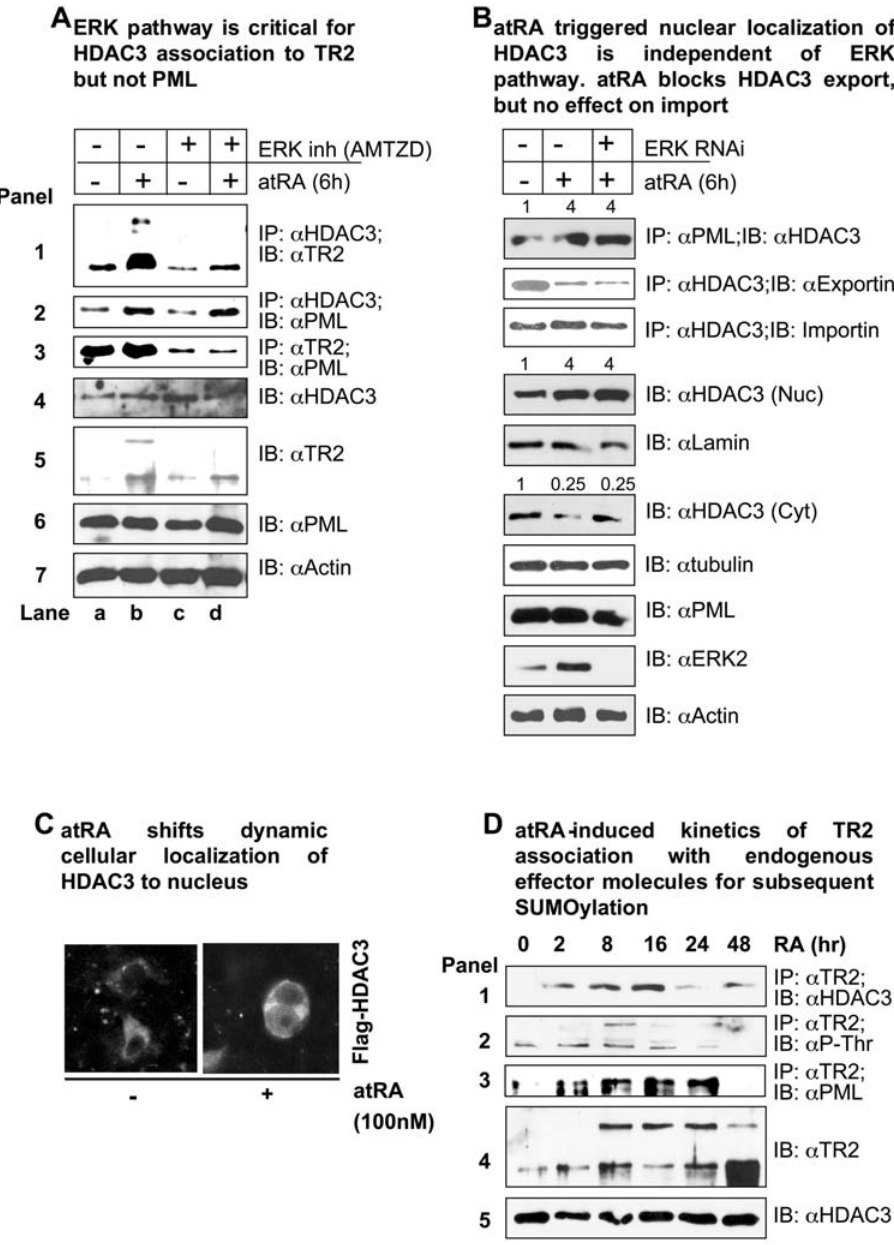
Figure 3. Effect of atRA and ERK on endogenous complexes with HDAC3. ( A ) ERK2-dependent association of HDAC3 to TR2 but not PML. ERK2 was inactivated pharmacologically and the atRA-triggered complex formation of HDAC3 with TR2 and PML was monitored. ( B ) Effects of atRA and ERK2 on HDAC-PML complex formation and HDAC3 subcellular distribution. Nuclear (Nuc)/cytoplasmic (Cyt) distribution of HDAC3 and its association with the import (Importin b ; Karyopherin ß 1) or the export (exportin 1, CRM1) machinery were monitored in coimmunoprecipitation (IP) experiments. Immuno blot (IB) panels show all input and protein controls. Numbers above the panels indicate quantified relative values. ( C ) atRA- triggered nuclear enrichment of HDAC3 in P19 cells, monitored by immunocytochemistry. ( D ) A kinetic study of endogenous components in P19 cells after atRA treatment at 0, 2, 8, 16, 24, and 48 h (panels 1–5).